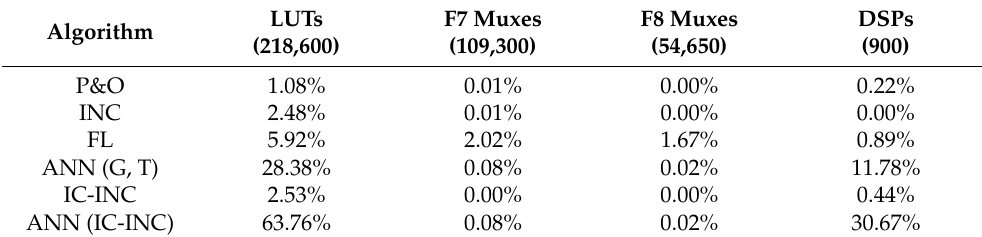
Table 5. Results of FPGA resources for different implemented